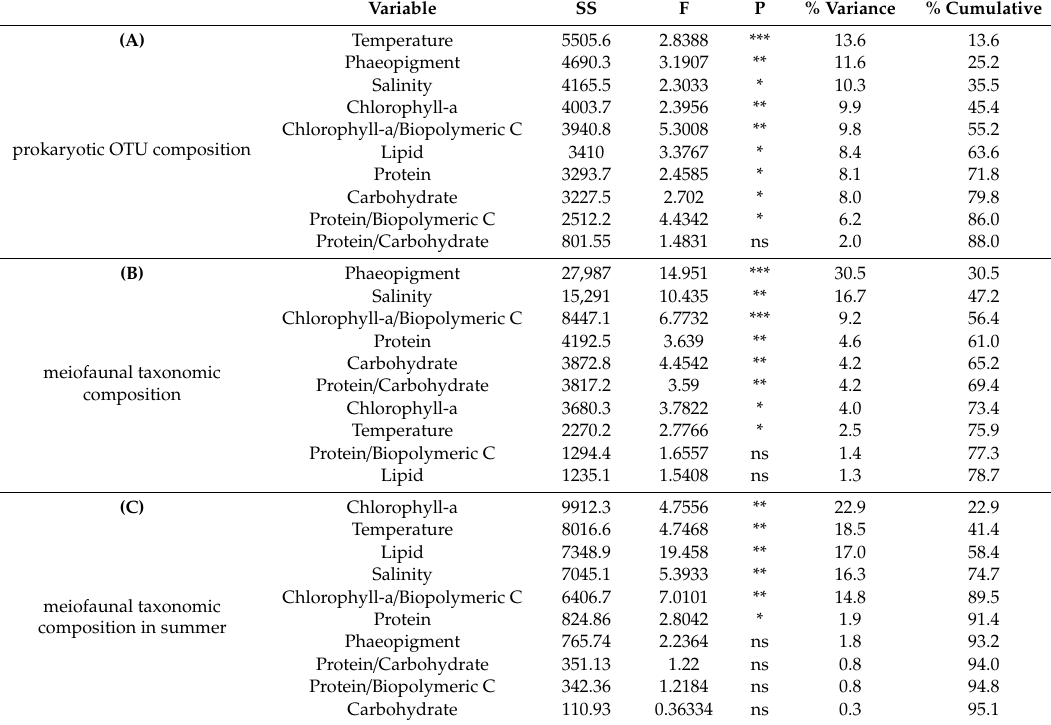
Table 3. Results of the multivariate multiple regression analysis carried out to ascertain the effect of the quantity and nutritional quality of sedimentary organic matter on the prokaryotic OTU composition ( A ) and meiofaunal taxonomic composition irrespective of the season ( B ), in summer, ( C ) and in winter ( D ). % Variance = percentage of explained variance (SS = sum of squares; F = F